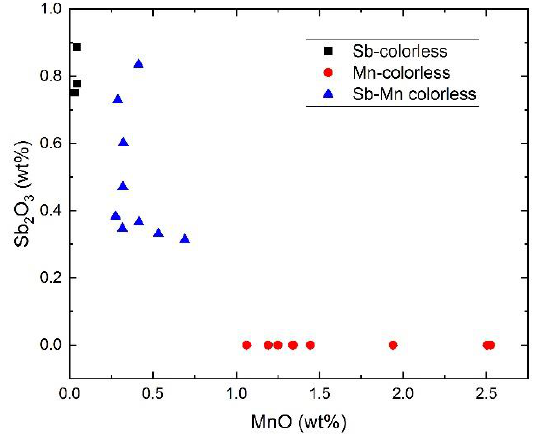
Figure 3. Plot of Sb 2 O 3 versus MnO concentrations in the colorless glass samples from Histria and Tomis discussed in this